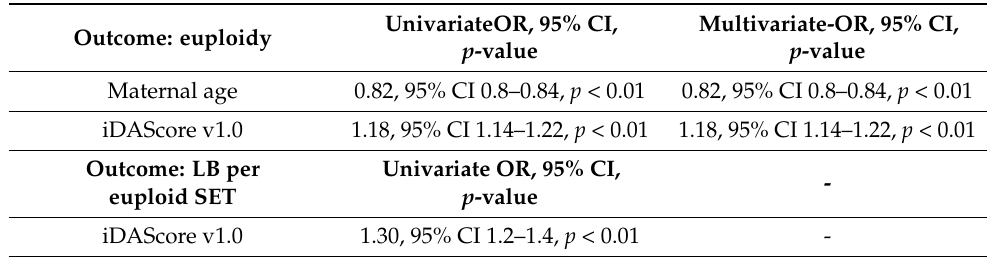
Table 1. Logistic regressions for the association between iDAScore v1.0 with euploidy (adjusted for maternal age) and live birth (LB) after euploid single embryo transfer (SET). Outcome: euploidy